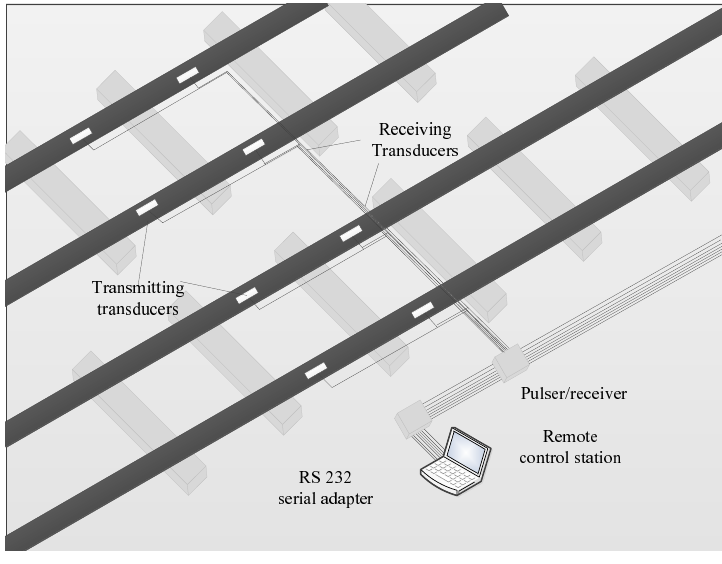
Figure 21. Arrangement of one of the 14 control